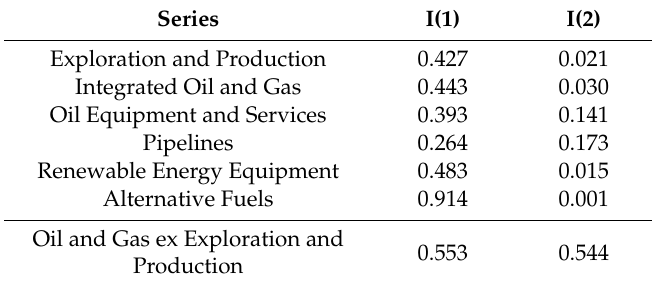
Table 7. p values from Dickey–Fuller tests of the weighted operating cash flow of the Oil and Gas